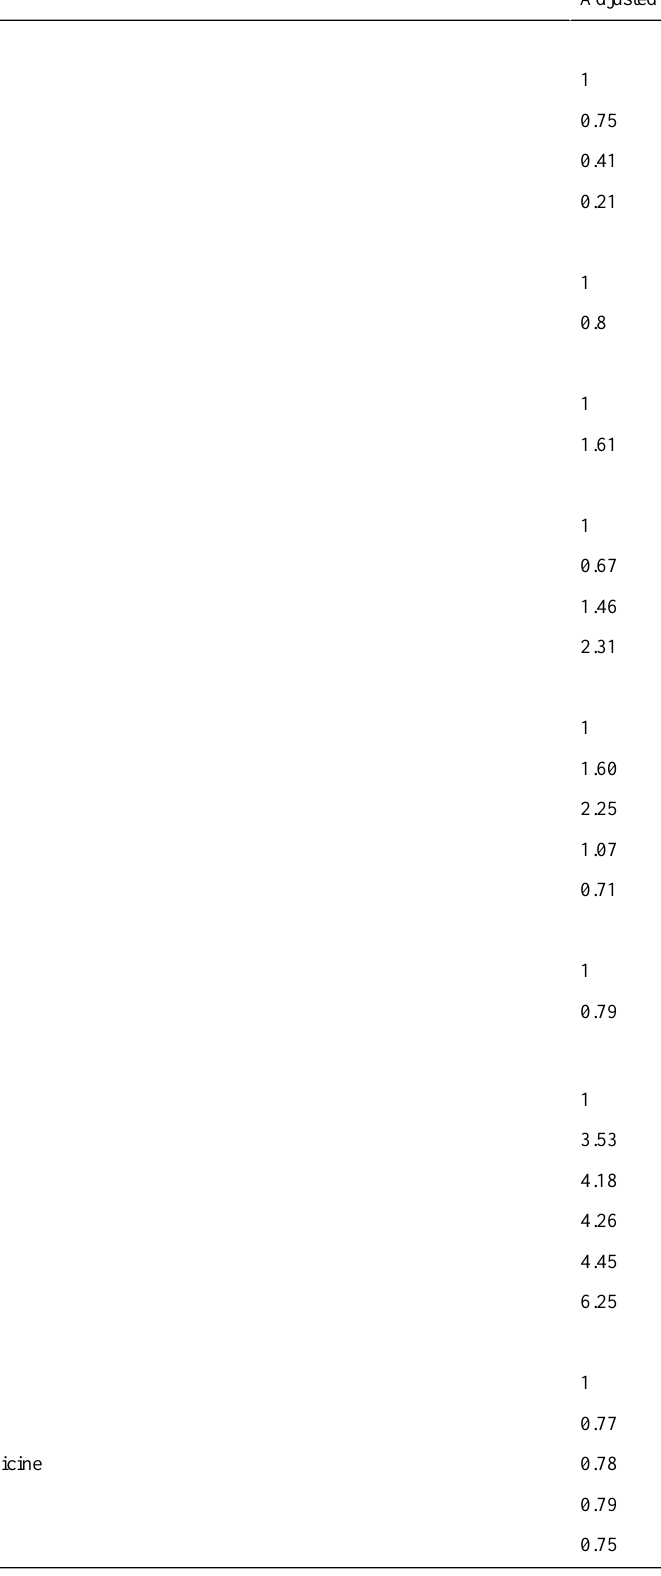
Table 6. Multivariable analysis of the factors associated with the use of the PDF download function in the Health4U app.